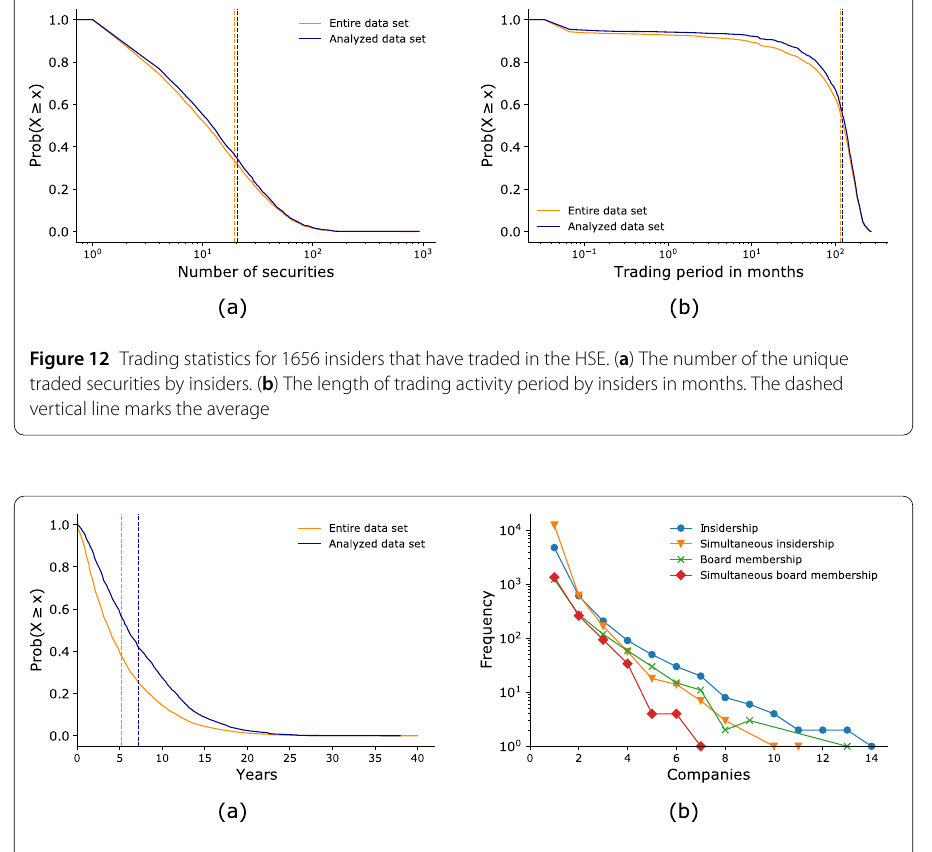
Figure 13 Length of insidership in companies of insiders and board members. ( a ) Length of insidership in a company in years for an insider. The dashed line marks the average length of insidership. ( b ) The number